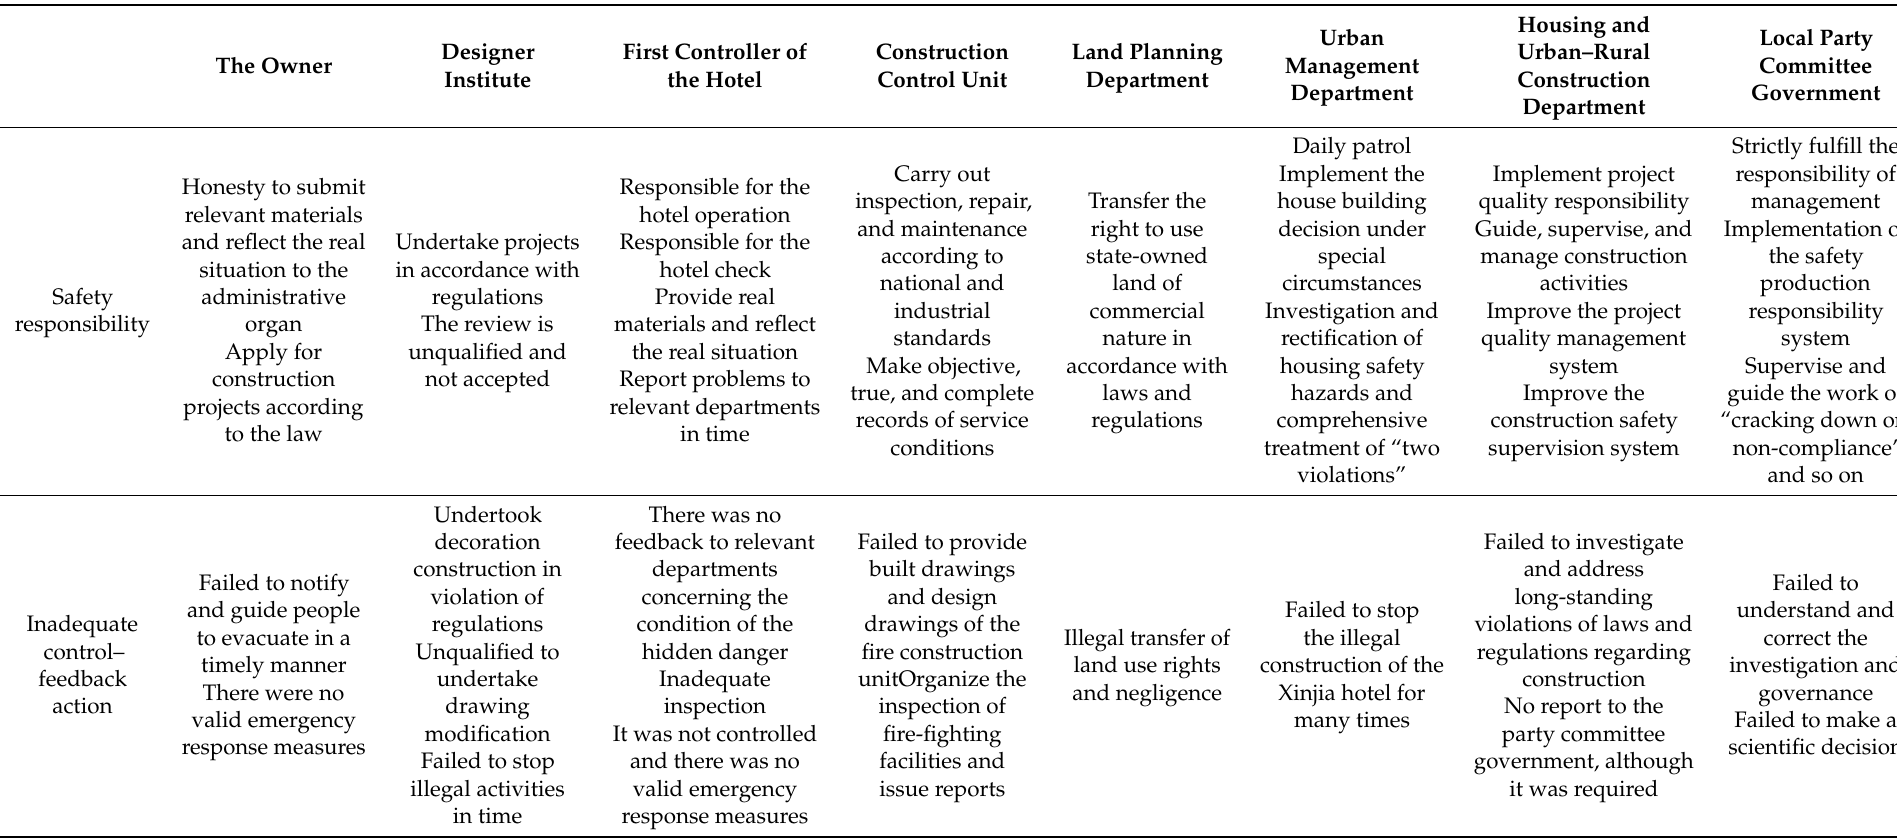
Table 2. Responsibilities, Actions, Contexts, and Models Flaws of the